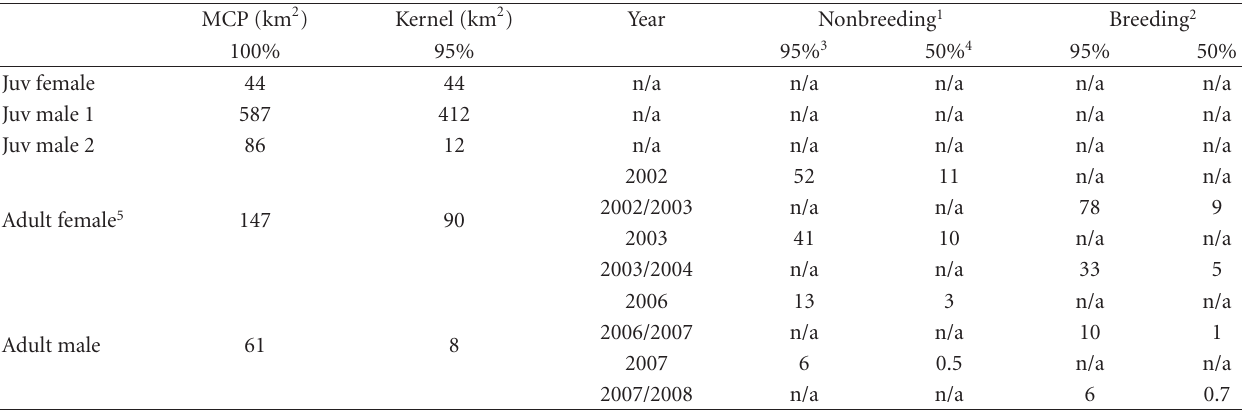
Table 1: MCP and kernel home range sizes.